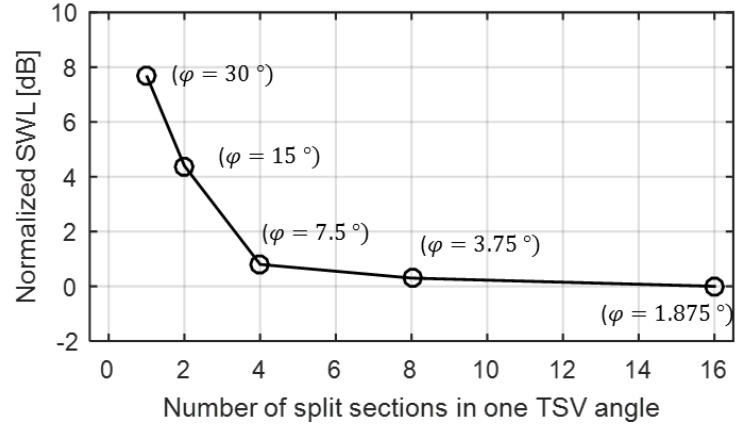
Figure 18. Normalized SWLs depending on the number of split sections in one TSV angle within the TSV pressure region.